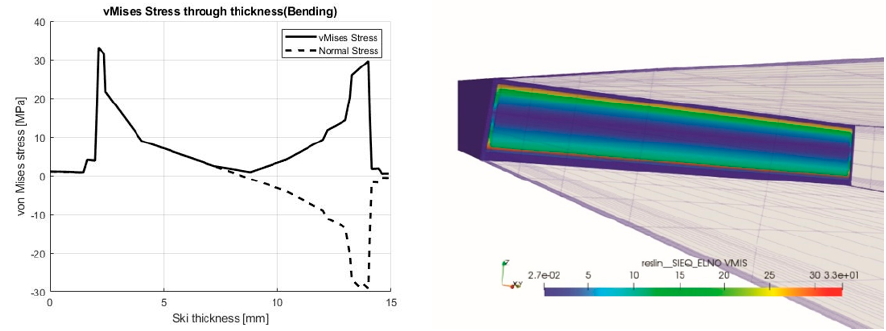
Figure 14. Solid model results—three-point-bending test (normal and Von Mises stresses in the section).